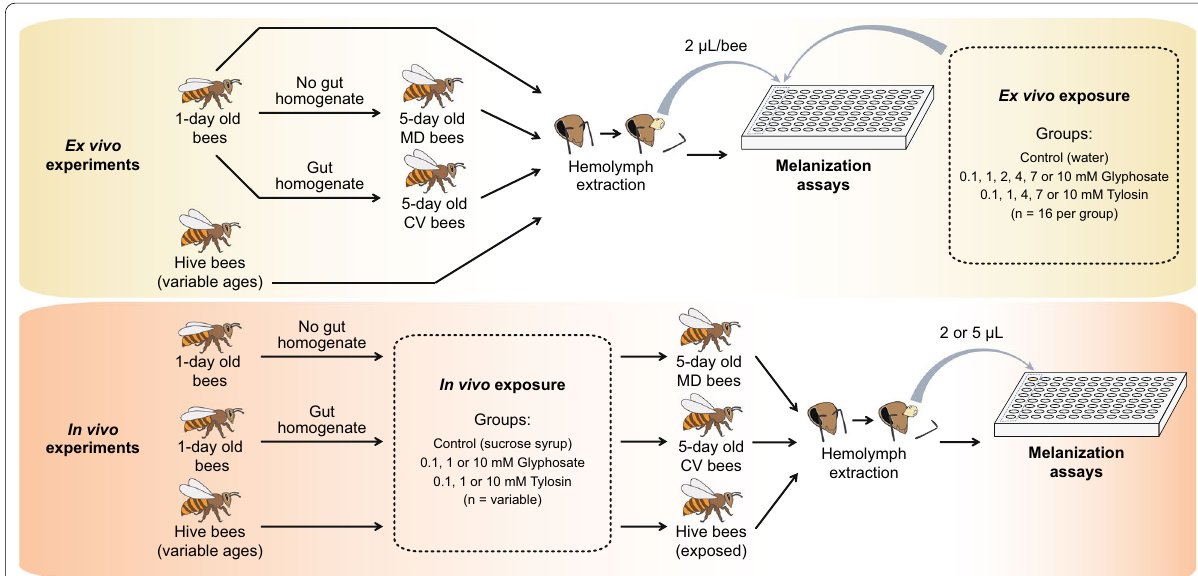
Fig. 5 Ex vivo and in vivo experiments to investigate the effects of glyphosate and tylosin on melanization in honey bees. Ex vivo experiments were performed with 1-day old bees, 5-day old bees lacking or containing a normal microbiota, and hive bees. 2 μL of hemolymph were extracted from individual bees and used along with variable concentrations of glyphosate or tylosin (0, 0.1, 1, 2, 4, 7 or 10 mM) in melanization assays. In vivo experiments were performed with 5-day old bees lacking or containing a normal microbiota and hive bees previously exposed to different concentrations of glyphosate or tylosin (0, 0.1, 1 or 10 mM) for 5 days. 2 μL or 5 μL of hemolymph were extracted from exposed bees and used in melanization assays. MD microbiota-defective, CV conventional